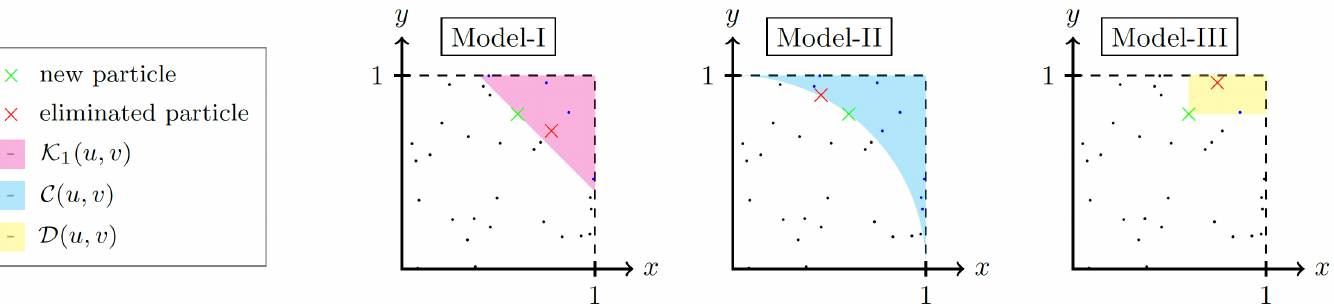
Figure 6: Illustrations of the